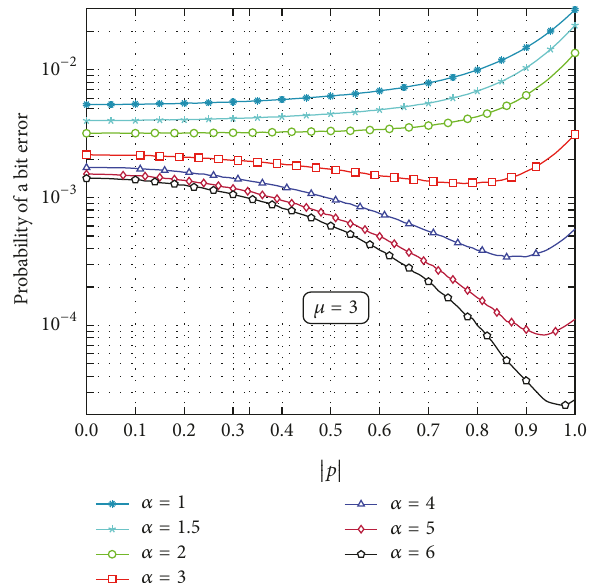
Figure 7: Average BER against the phase parameter 𝑝 under 𝛼 - 𝜇 fading channel with SNR = 20 dB, 𝐿 = 3 , and 𝜇 = 3 .